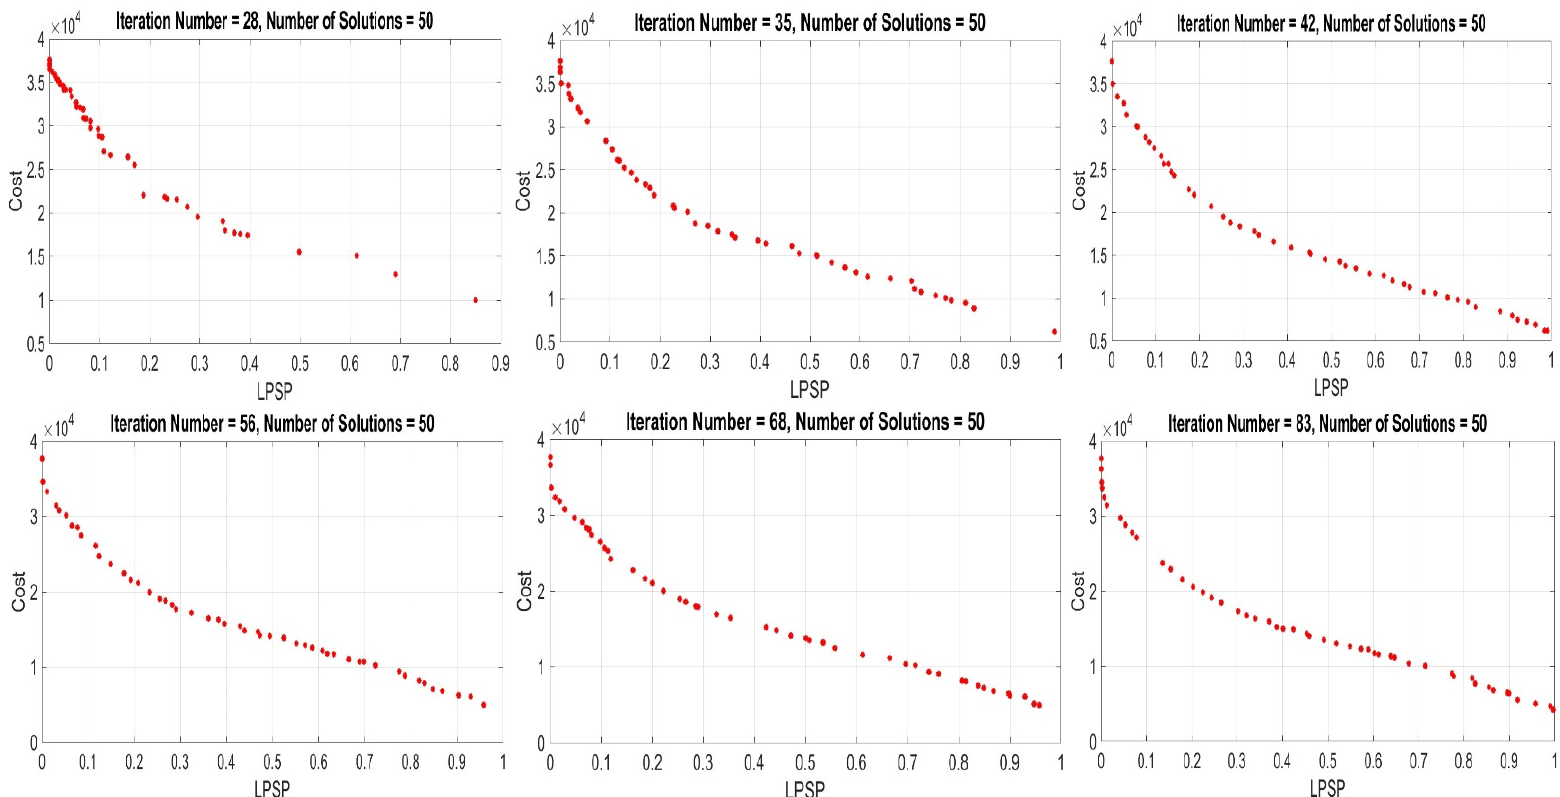
Figure 6. Gradual convergence of the solutions in NSGA-II.